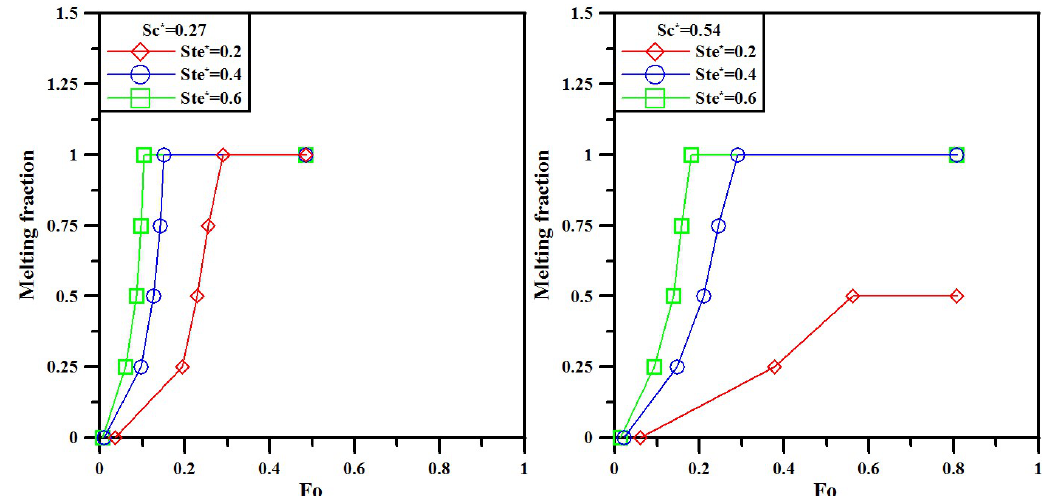
Figure 4. The melting fraction as a function of dimensionless time Fo under constant temperature boundary conditions.